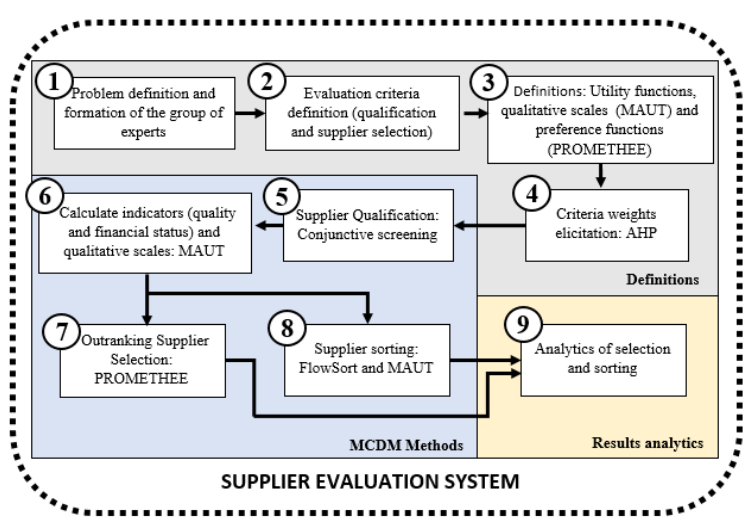
Figure 1. Supplier evaluation system for the banking sector.